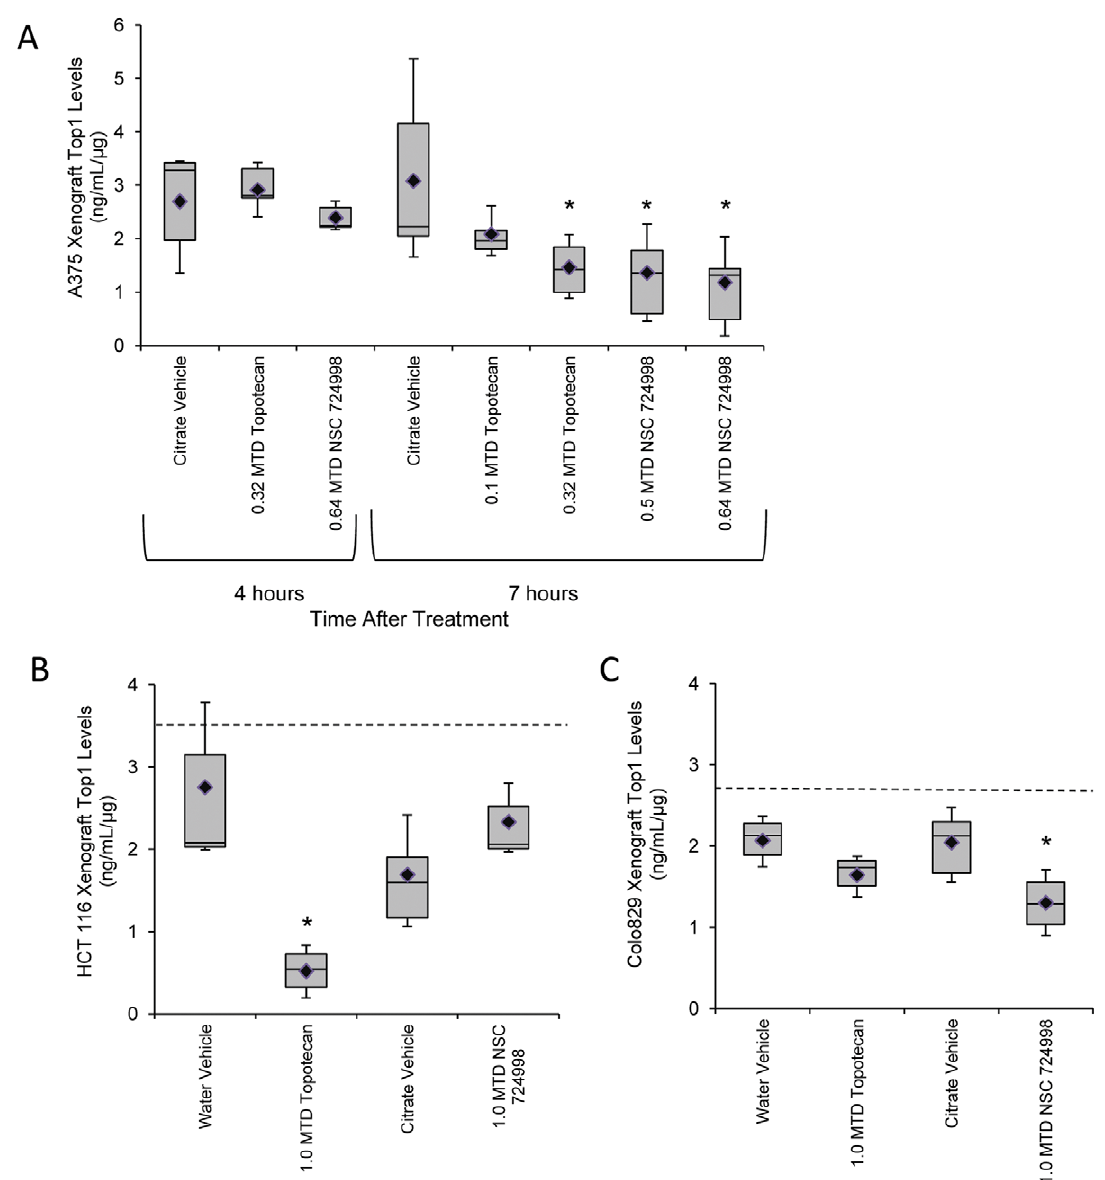
Figure 4. Top1 levels measured in xenografts treated with topotecan compared to two indenoisoquinoline topoisomerase inhibitors. (A) Top1 levels in A375 xenografts collected 4 or 7 hours following single dose treatment (MTD indicated) with topotecan or the indenoisoquinoline NSC 724998 (n=5–6 mice/cohort). (B) HCT 116 xenografts and (C) Colo829 xenografts collected 4 hours after mice were treated with the indicated doses and drugs. (n=3–6 mice/cohort; NSC 724998 had 2 mice/cohort). Box plots represent interquartile range, 10 th and 90 th percentile whiskers, and median Top1 levels; diamonds represent group mean. Dashed lines in panels B and C indicate the mean Top1 levels in a matched untreated cohort (0 h) for these xenograft models. Asterisks (*), treatment cohort mean was statistically different from vehicle mean at same time point, with a significance level of P # 0.05, as determined by Student’s one-tailed t -test.